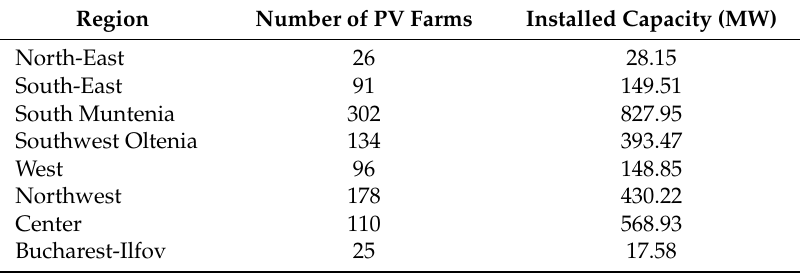
Table 3. No. of PV farms and installed capacity in Romania,